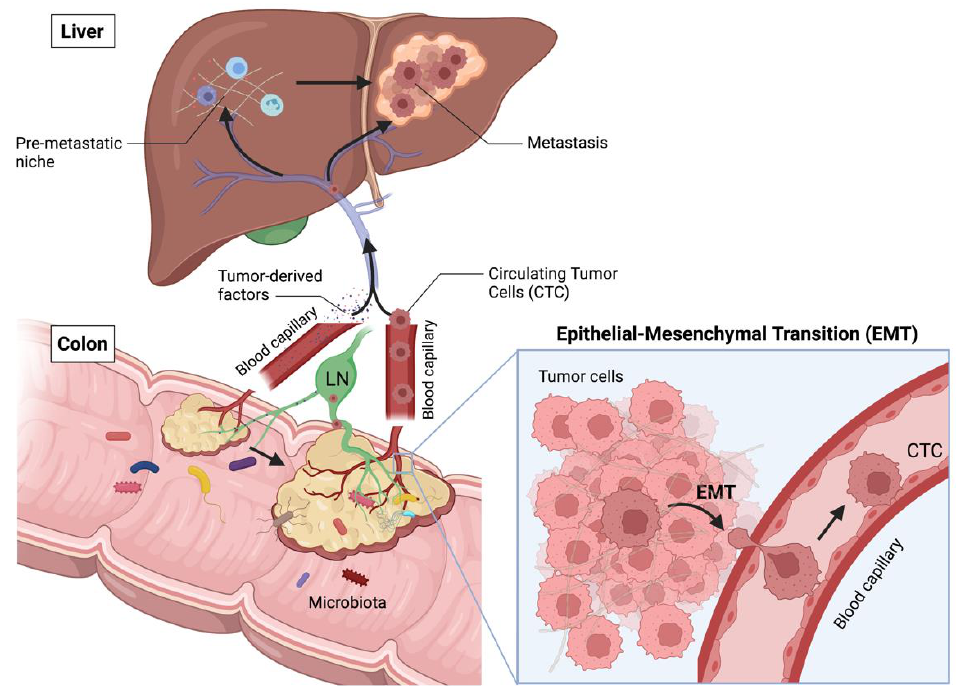
Figure 2. CRC progression from the primary tumor to metastasis. Primary tumor growth in the colon or rectum increases gut permeability, resulting in microbial infiltration in the tumor. In parallel, tumor-secreted factors induce the formation of PMNs in distant sites. Some cancer cells undergo EMT to intravasate and circulate as CTCs in blood or lymphatic vessels, until extravasation in a distant tissue, preferentially at the PMNs, where they form tumor metastasis upon growth (LN: tumor-draining lymph node).